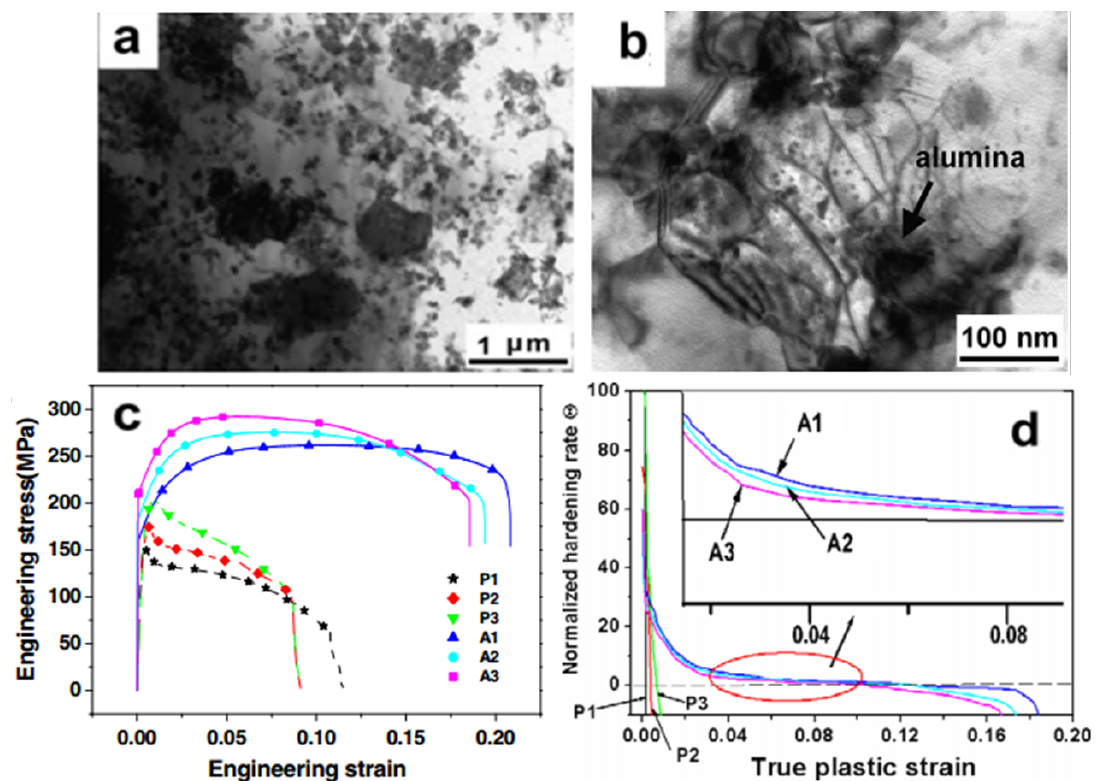
Figure 3: (a) the uniformly distributed alumina particles in aluminum matrix (b) the intensive interaction between alumina nanoparticles and dislocations (c-d) engineering stress-strain curves and normalized hardening rate of the as-produced Al samples in other refs [19].